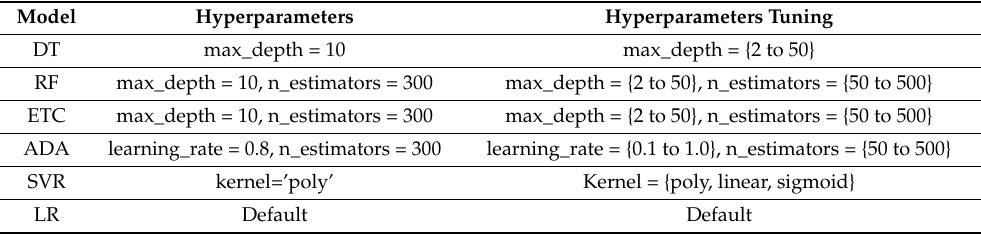
Table 6. Regression models hyperparameters setting for water consumption